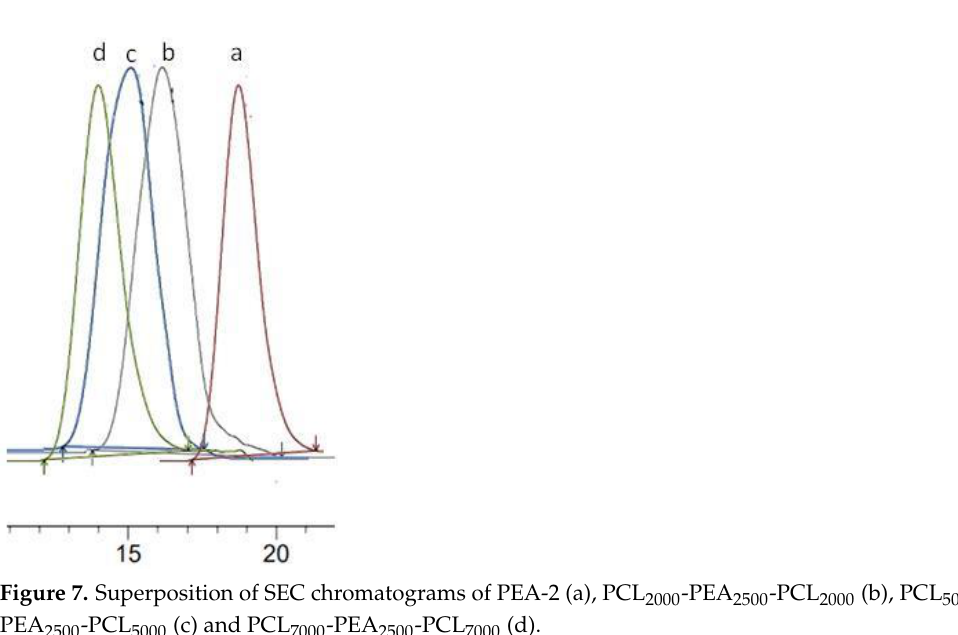
Table 3. Molecular characteristics of PCL-b-PEA-b-PCL copolymers.